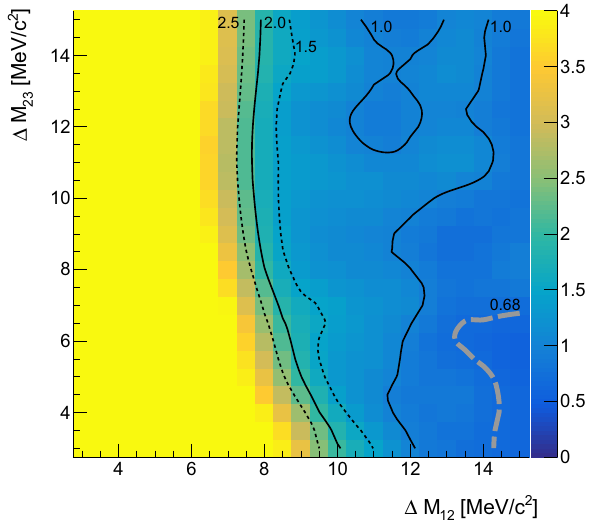
Fig. 5 90% C.L. upper limit on f 1 , as function of the chosen Υ J ( 1 D ) fine splitting values. The black lines represent the curves at fixed values oftheULinstepsof0.5.ThecorrespondingULvalueisreportednextto eachline.Dashedandsolidlinestylesarealternatedforclarity.Thethick gray dashed line demarcates the region excluded by the theoretically- favored value f 1 = 0 . 68 [37]